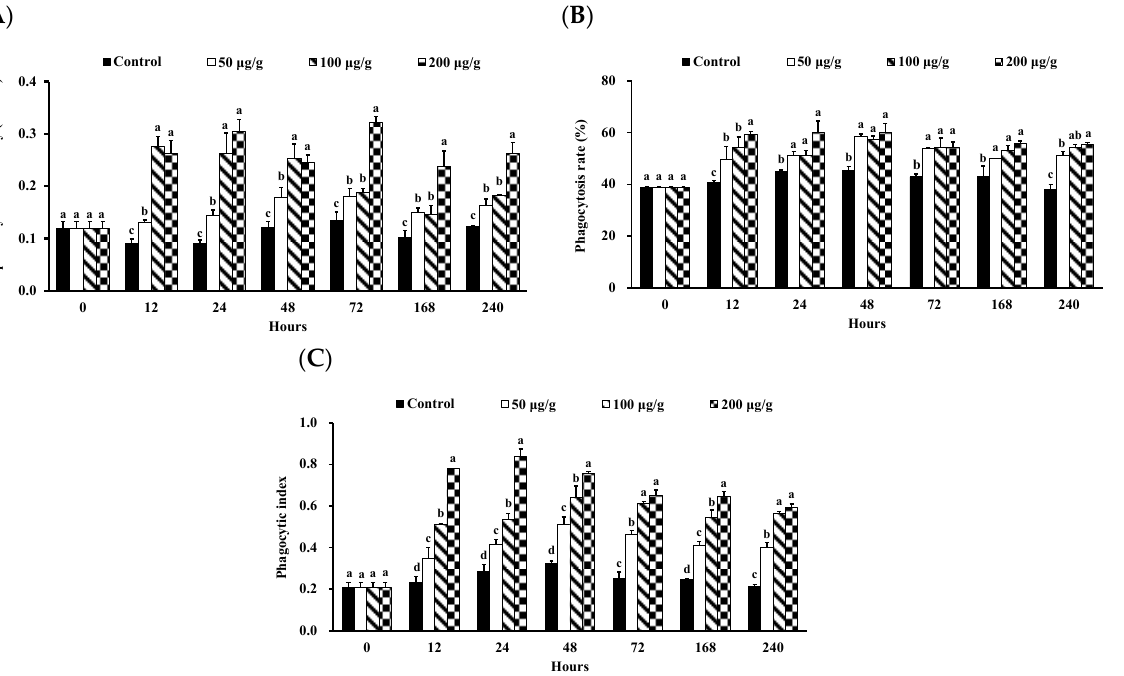
Figure 3. RB ( A ) activity, PR ( B ), and PI ( C ) of Litopenaeus vannamei that received the water extract of Panax notoginseng at 50, 100, and 200 µ g (g shrimp) − 1 and control shrimp. Data are expressed as mean ± SD ( n = 8). Different superscript letters indicate that the same exposure time significantly differs ( p < 0.05) among groups (Duncan’s multiple range tests).